Question: What type of chart is this?
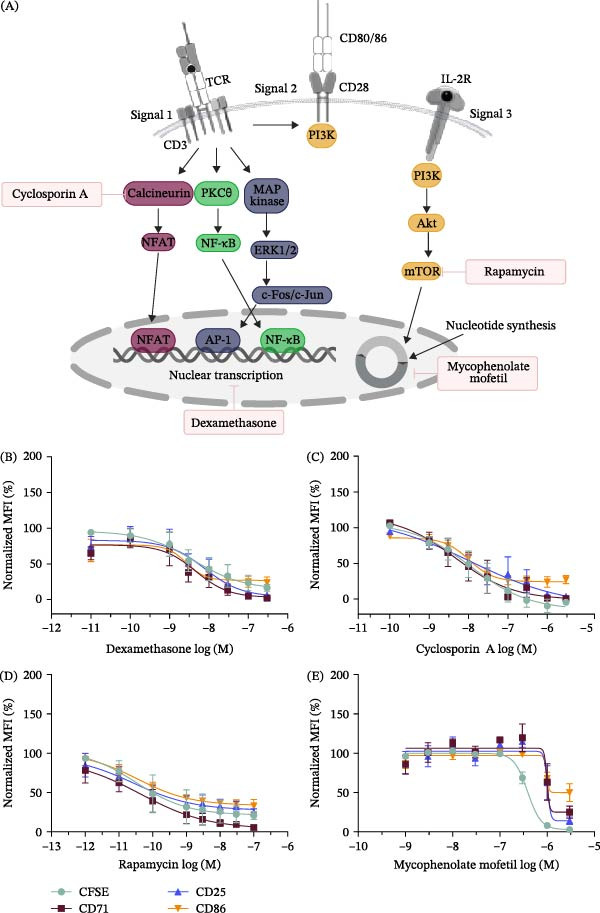
Answer: line